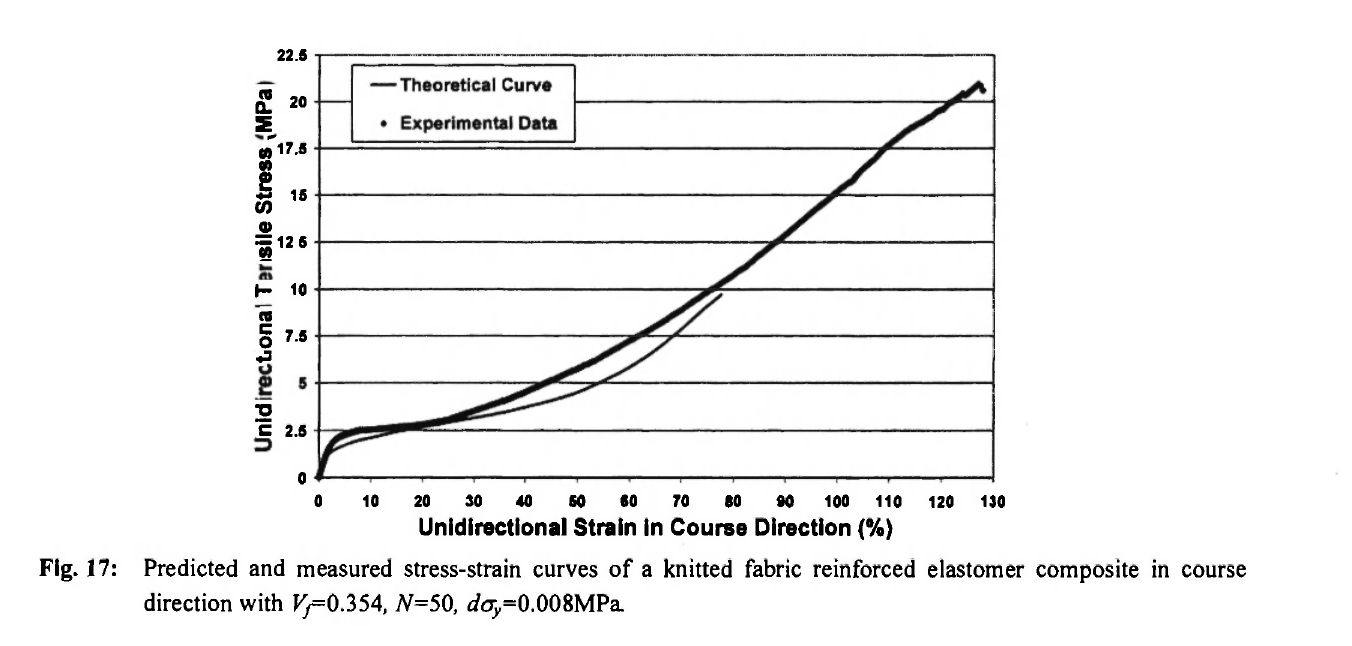
Predicted and measured mechanical properties of the